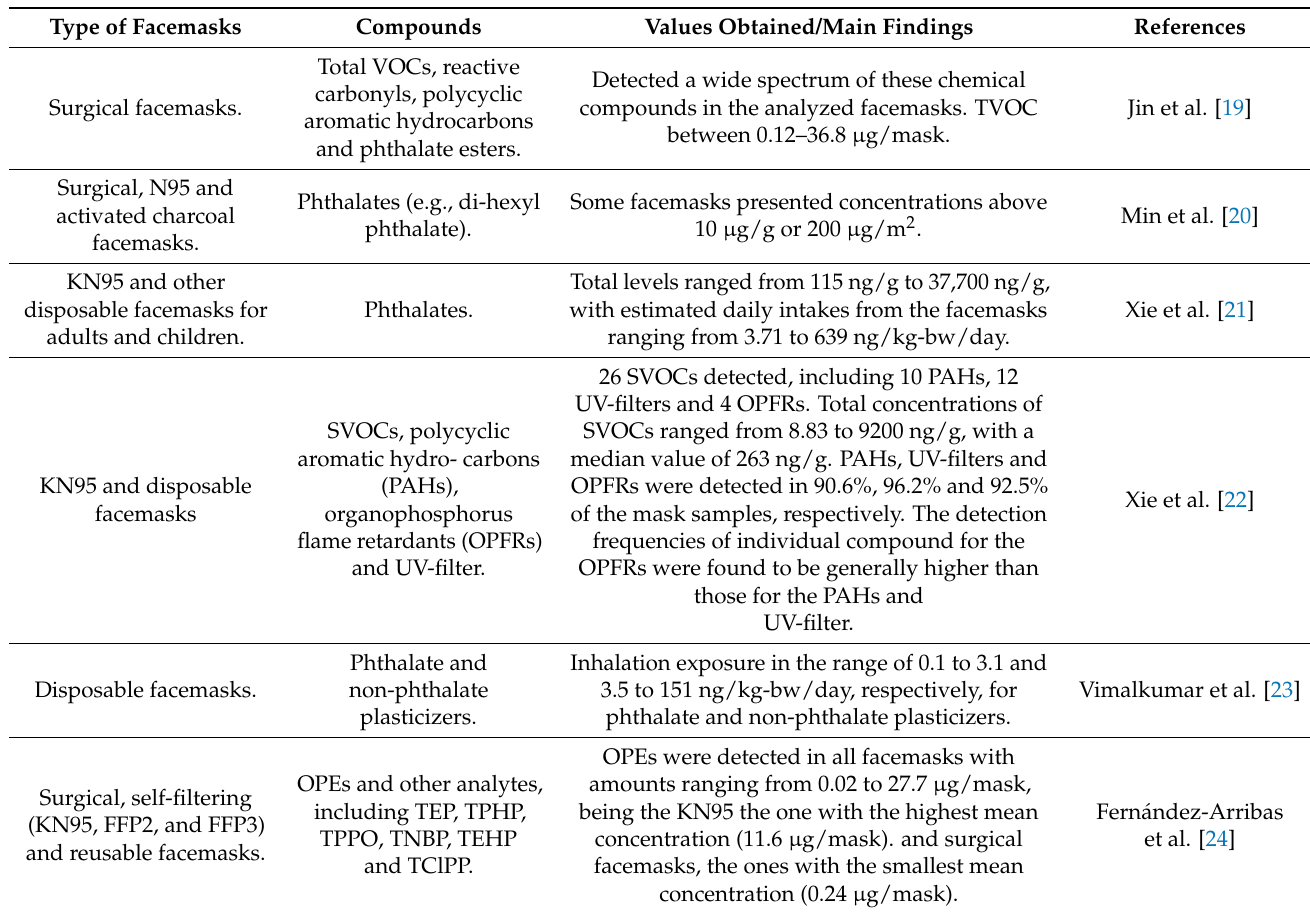
Table 1. Summary of chemical compounds analyzed in facemask’s